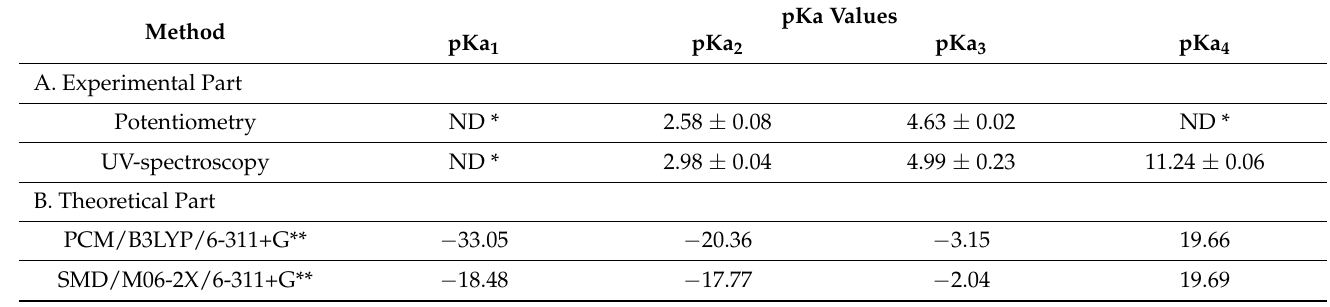
Table 4. The values of dissociation constants obtained experimentally A . for protonated 2Cl3HP determined at 25 ◦ C in an aqueous medium from n titrations (I = 0.01 M NaClO 4 ; n ≥ 3); standard deviations computed thereby refer to random errors only. For comparison pKa values obtained by DFT approach B